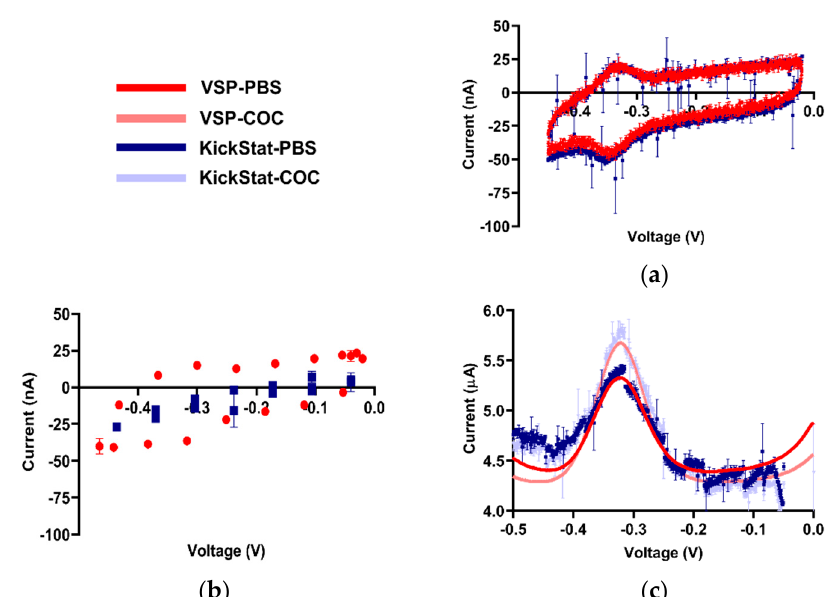
Figure 4. Qualitative comparisons between KickStat (blue) and the commercial device (red) while measuring cocaine biosensor. ( a ) Comparative readout of the cyclic voltammogram for the cocaine aptamer in phosphate-buffered saline (PBS) displaying minimal redox peak separation characteristic of an adsorbed species, indicating successful functionalization of the electrode, ( b ) Cyclic voltammogram with the lower resolution LMP91000 stock voltage reference generator and corresponding points using the commercial device. Peaks are not discernible by eye or by commercial device’s software, making analysis of the electrochemical current virtually impossible, ( c ) Square wave voltammograms in PBS and 0.5 mM cocaine hydrochloride. Data points shown for each device are the average of 3 sequential runs. Error bars represent standard deviation and are smaller than the points plotted in many cases. Voltages are referenced against an Ag/AgCl reference electrode.